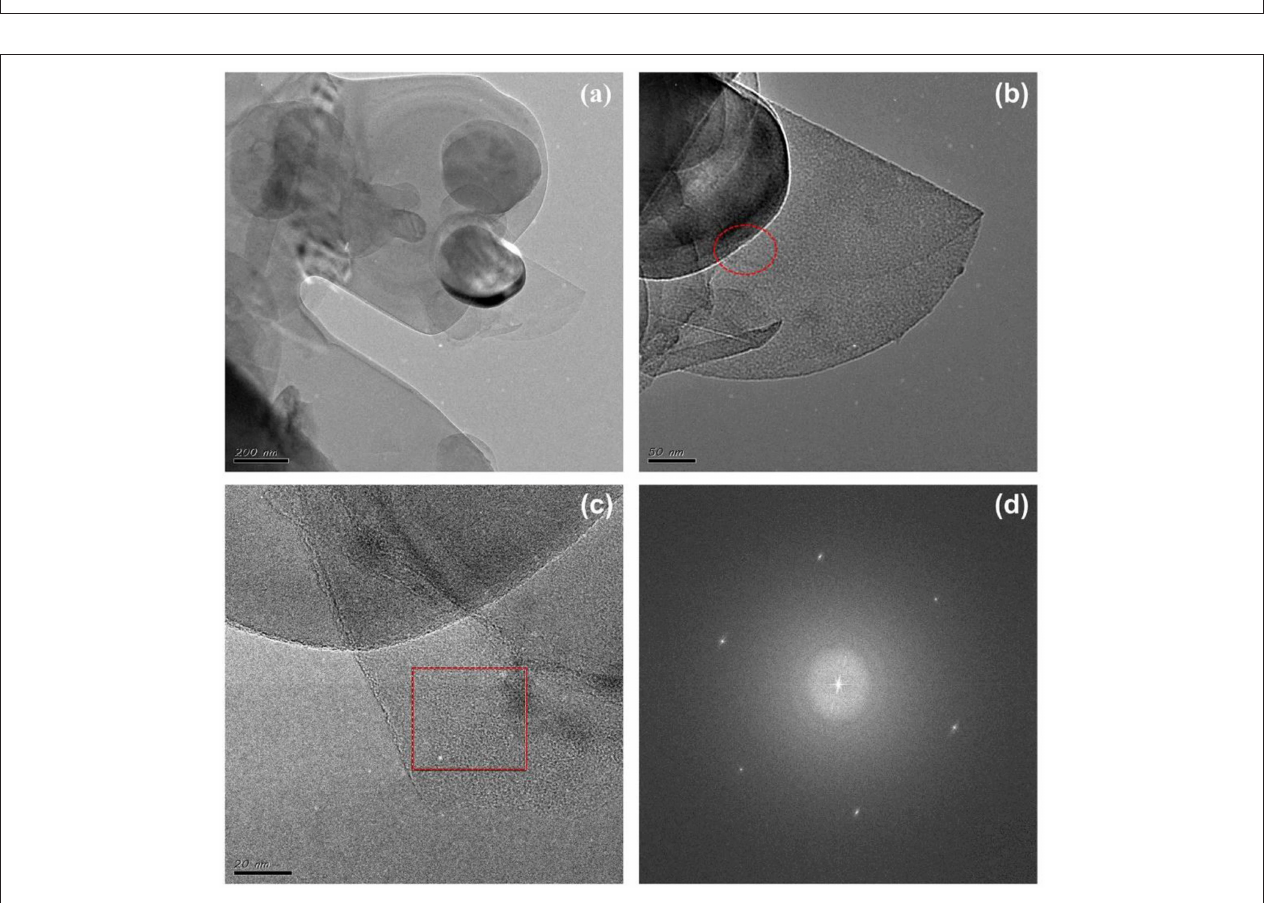
FIGURE 3 | The TEM (a–c) and FFT (d) images of h-BN nanosheets. was also more than 5 um, which as similar with the observed size of TEM and SEM. Based on the theoretical thickness of graphene (0.34 nm), the thickness of two adjacent areas in view of Figure S2 is about 0.68 nm (Pattammattel and Kumar, 2015). This value indicated that the as-prepared graphene was close to